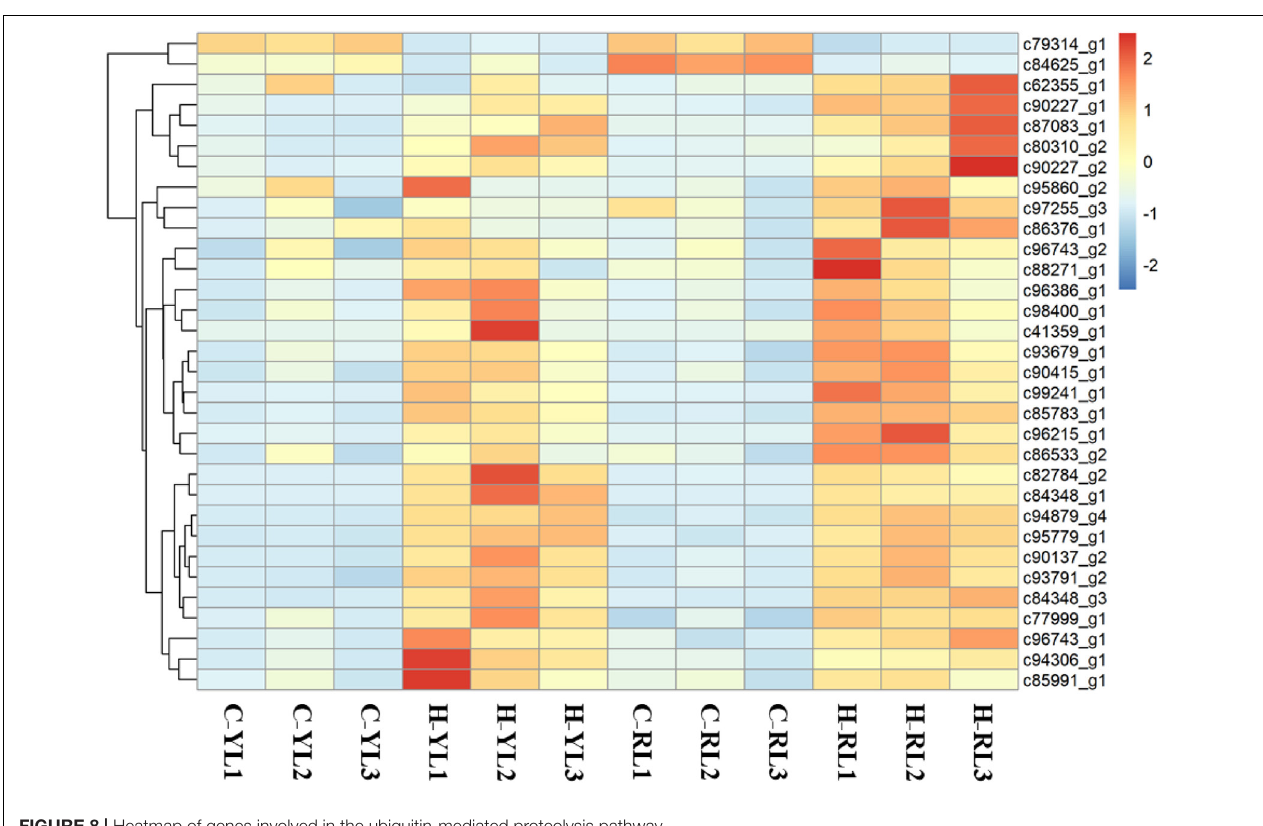
FIGURE 8 | Heatmap of genes involved in the ubiquitin-mediated proteolysis pathway.